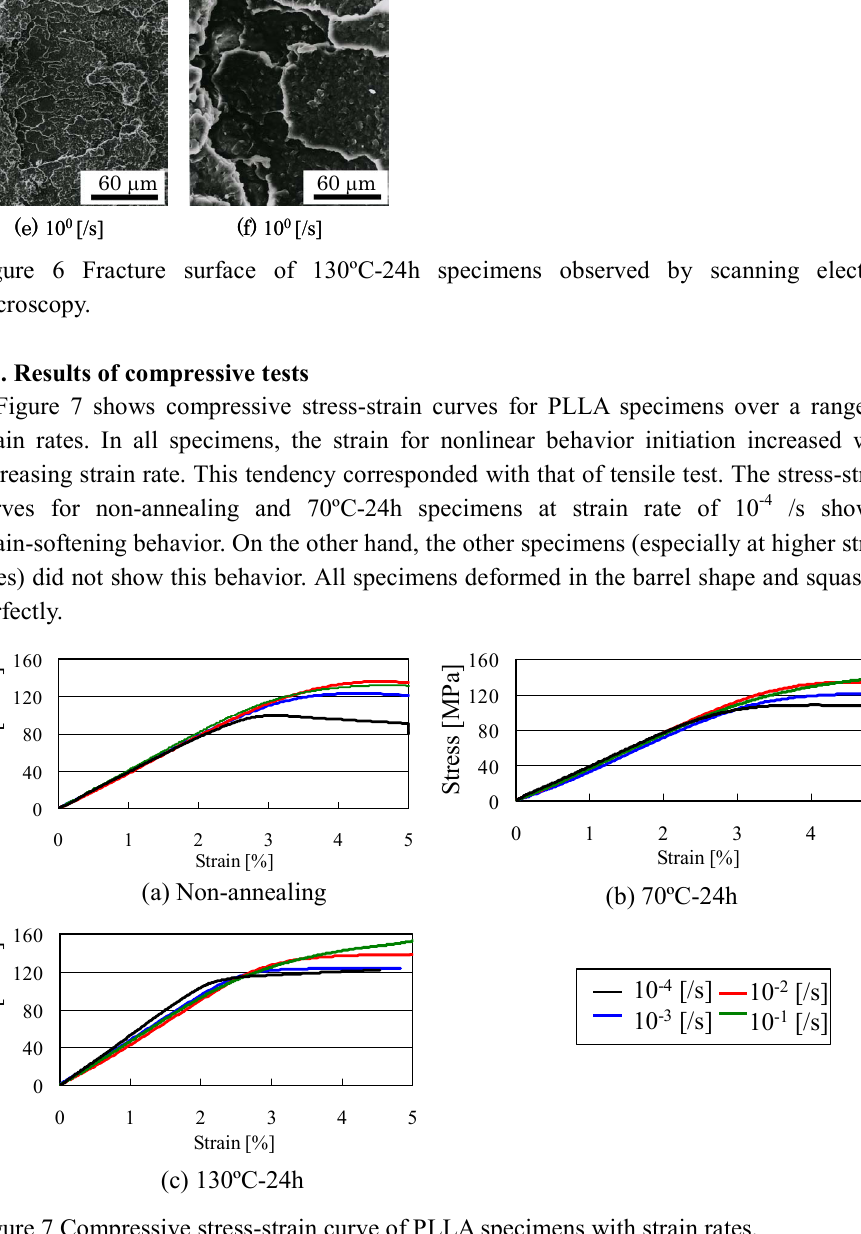
Figure 7 Compressive stress-strain curve of PLLA specimens with strain